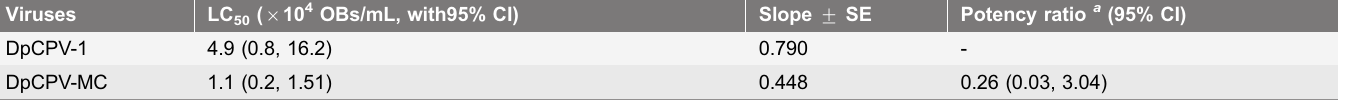
Table 2. Median lethal concentrations (LC 50 ) of DpCPV-MC and DpCPV-1 against second-instar S. exigua